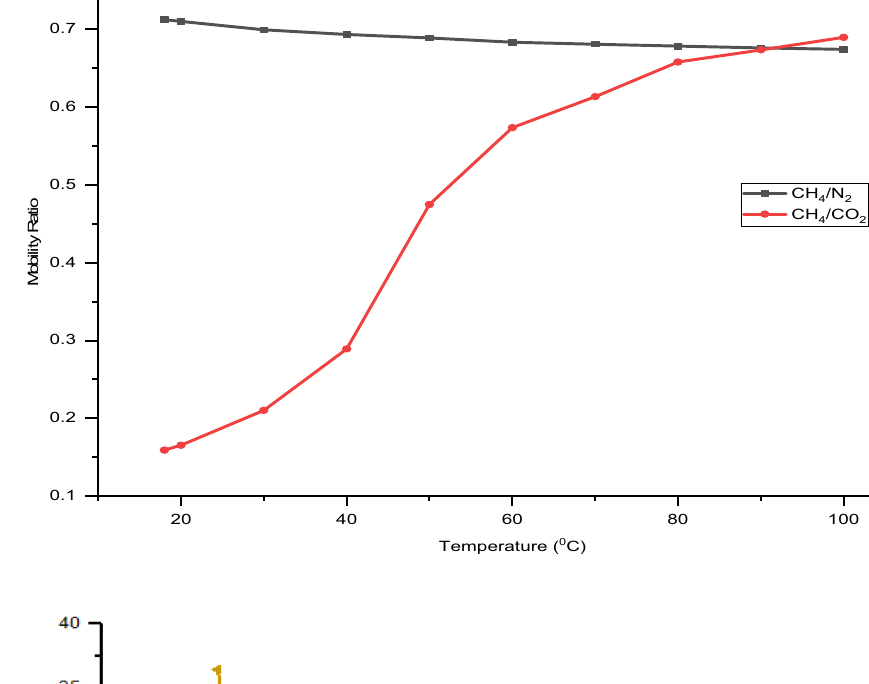
Fig. 7 Effect of pressure on dif- fusion coefficients for CH 4 –N 2 and CH 4 –CO 2 interaction at constant temperature of 30, 40, and 50